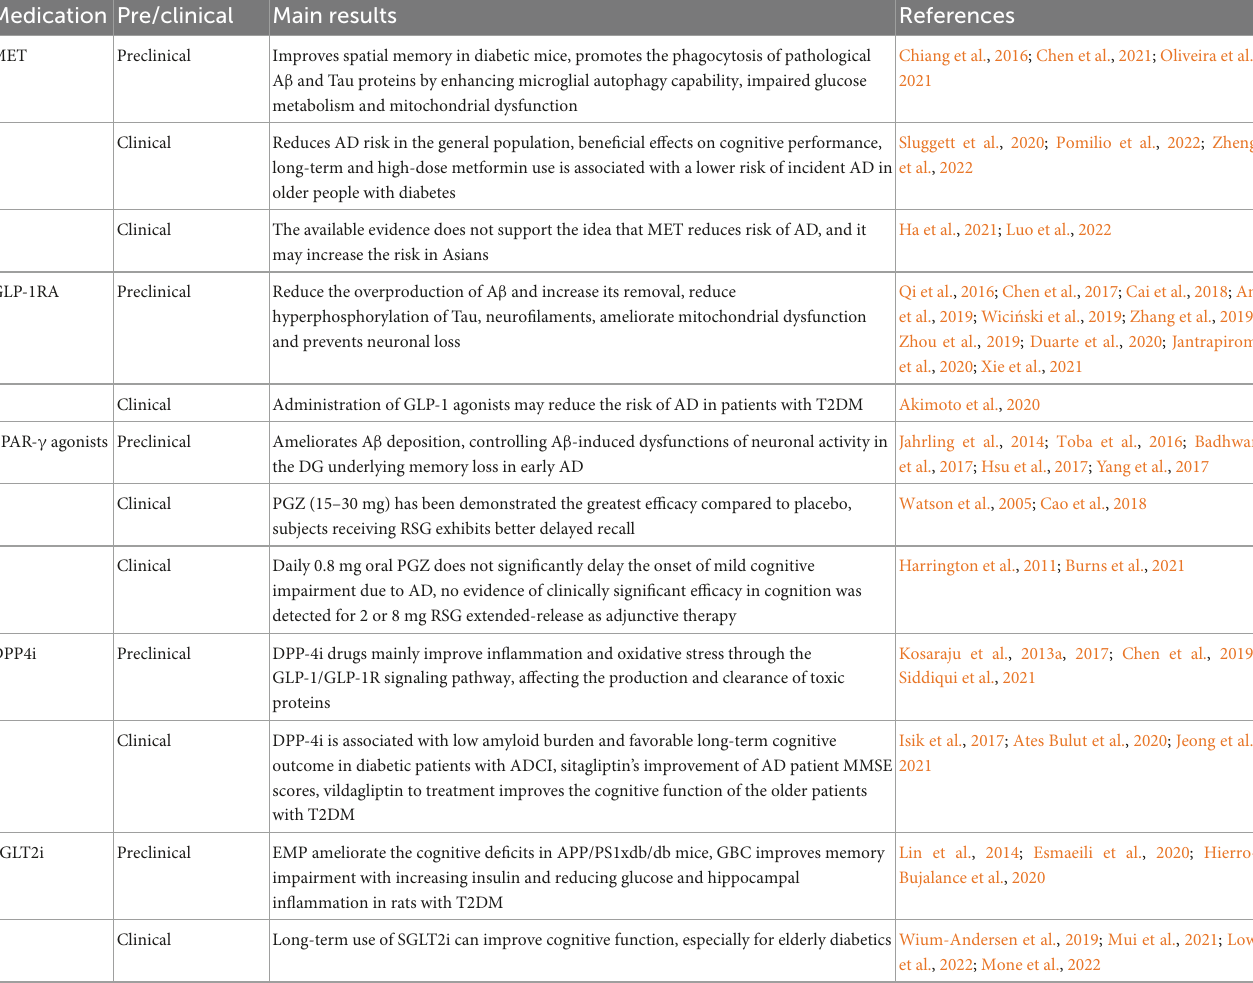
TABLE 1 Clinical antidiabetic medication used in